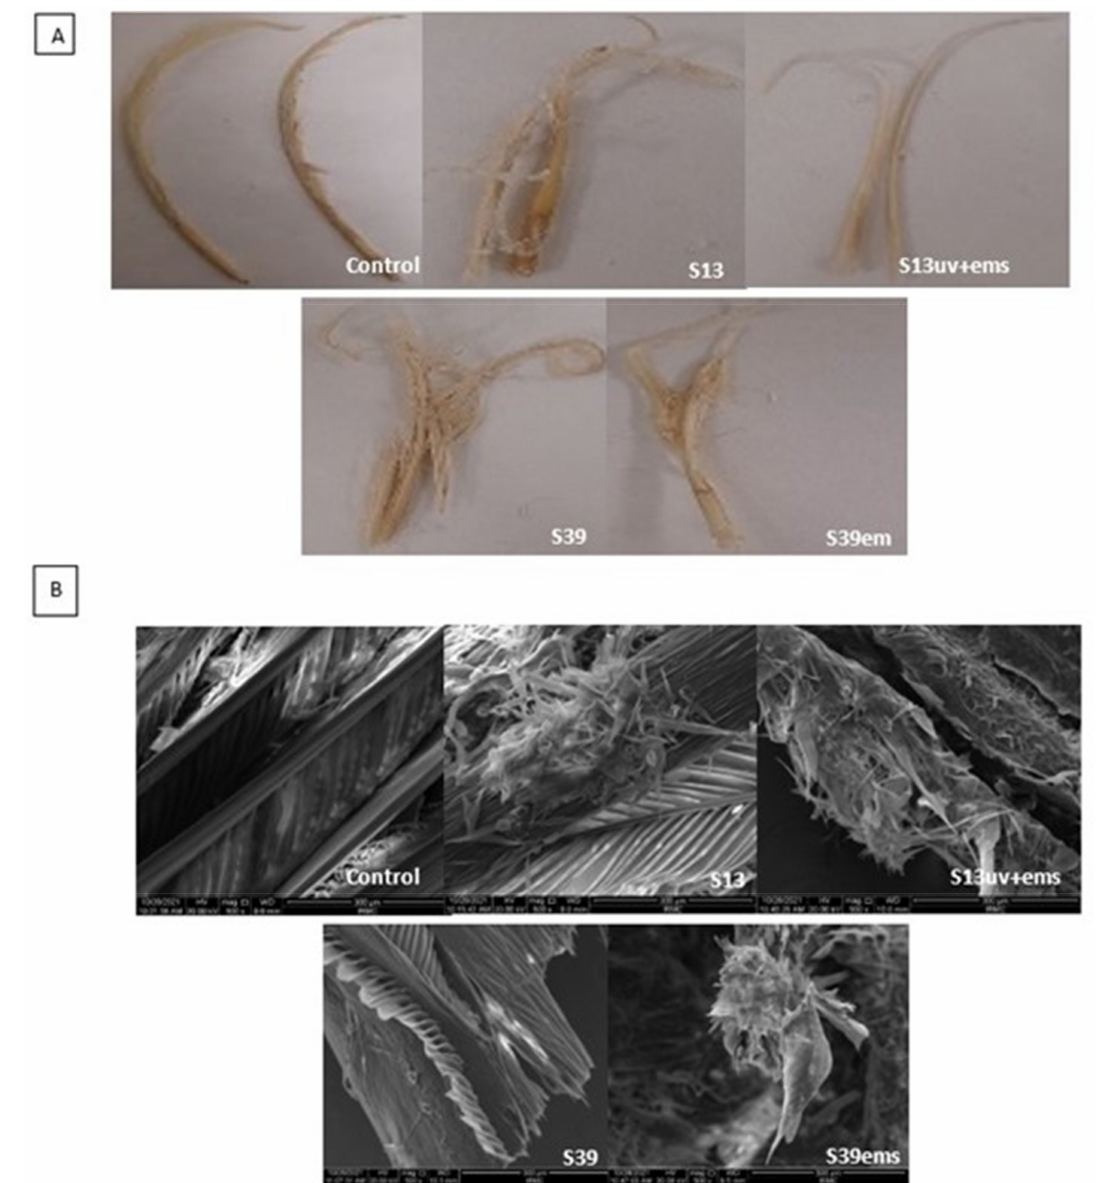
Figure 6. Evaluation of biodegradation efficiency of the wild and mutant isolates. ( A ) Feathers degradation after 72 h of incubation with isolates S13 and S39 and their mutants S13uv+ems and S39ems examined by digital camera and ( B ) scanning electron